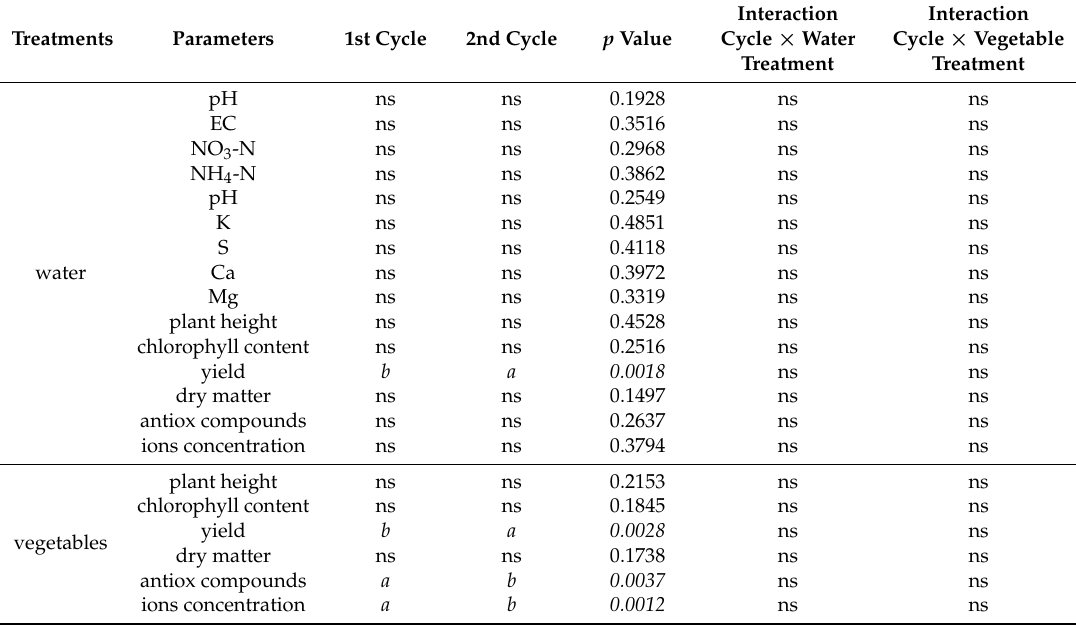
Table 3. Statistical analysis (ANOVA) overview of the two growth cycles, comparing water and vegetables